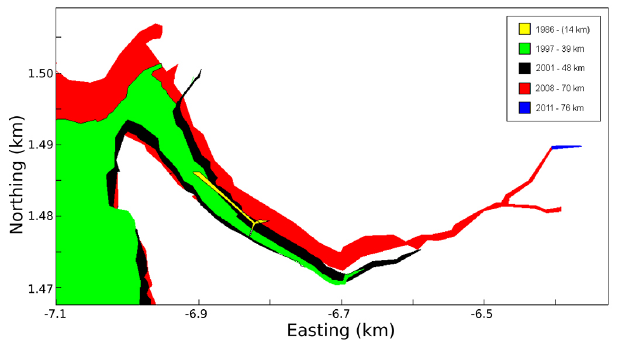
Fig. 9. The evolution of the Brunt-Stancomb chasm over time. The shape of the chasm at different times is is shown as coloured poly- gons. The non-coloured (white) area in the figure above and below the chasm are parts of the BIS and the SWGT, respectively. The length of the chasm, from the south promontory to the furthest vis- ible end of the chasm in the interior, is shown in the legend of the figure.